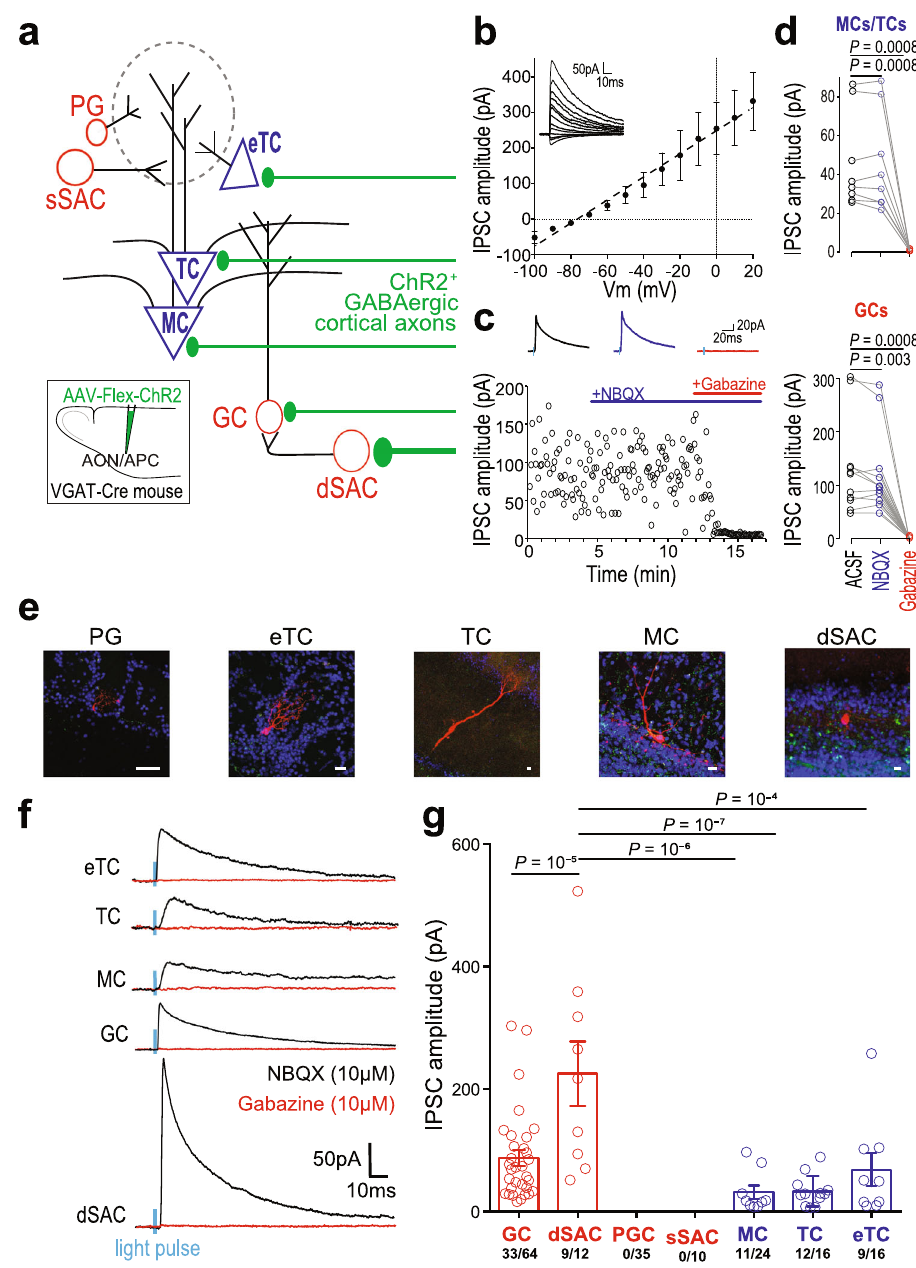
Fig. 3 | Cortico-bulbar GABAergic axons form functional synapses with inhi- bitory and excitatory neurons in the OB. a Recording schematic.Periglomerular (PG) cells, external tufted cells (eTCs), super fi cial short-axon cells (sSACs), tufted cells(TCs),mitralcells(MCs),granulecells(GCs)anddeepshort-axoncells(dSACs) were patched and GABAergic feedback axons expressing ChR2 (inset) were light- stimulated (2ms). Width of the axon shafts indicates connection probability. b PSCs recorded inGCs ( n =4 cells)atdifferent holding potentials, inthe presence of NBQX (10 µ m). Responses reversed at ~ − 75mV, consistent with GABAergic receptor activation. In the rest of the fi gure, V c =0mV. c IPSC amplitudes in an example GC in the presence of ACSF, NBQX or Gabazine. d PSCs were resistant to NBQX application (10 µ M) but completely abolished by Gabazine (SR95531, 10 µ M) in MCs/TCs (top) and GCs (bottom; GCs: One-way ANOVA, F (2,33)=9.82, p =10 − 4,